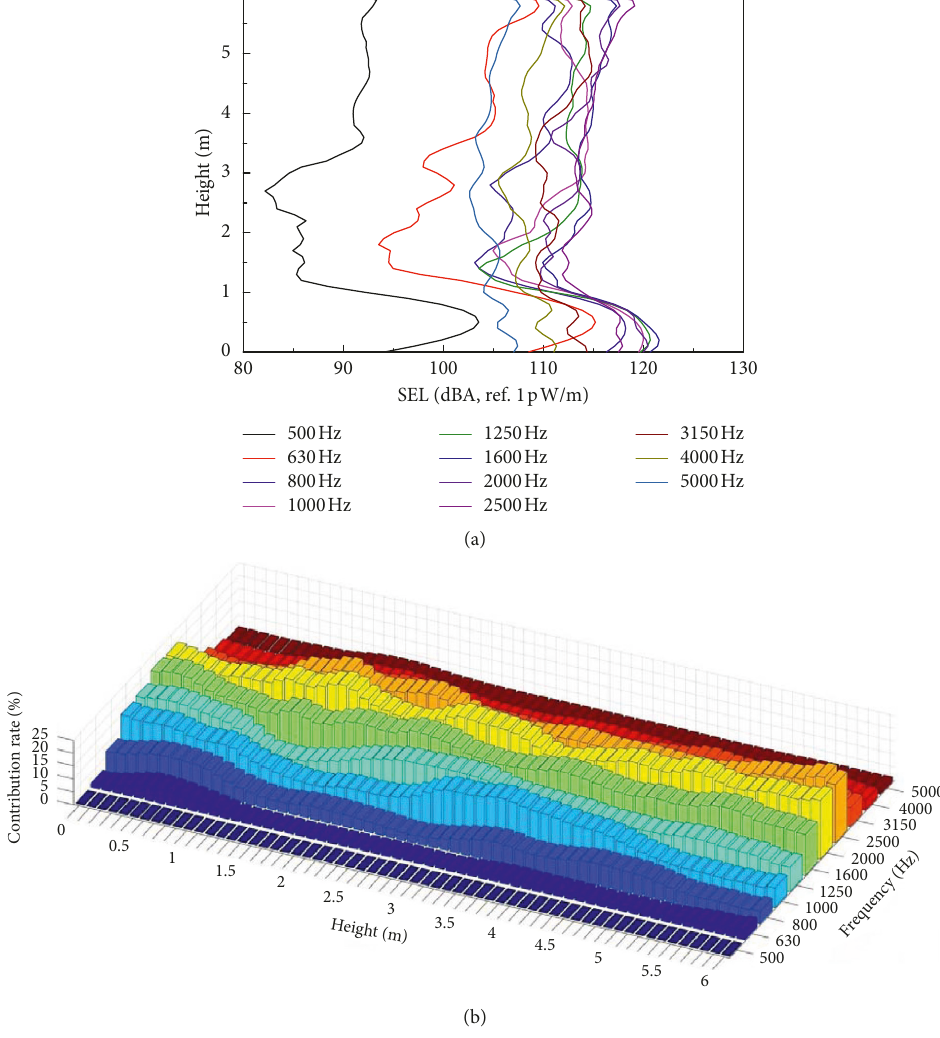
Figure 11: Frequency characteristics of the exterior noise sources in the vertical direction (350 km/h). (a) Frequency distributions. (b) Frequency contribution